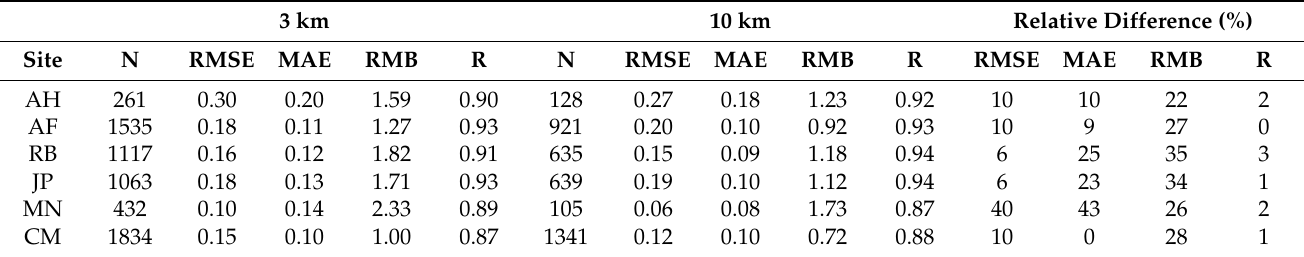
Table 2. Statistical parameters calculated for the linear regression models between AOD AERONET and AOD MODIS DT 3 km and 10 km: Amount (N) of observations of the AERONET and